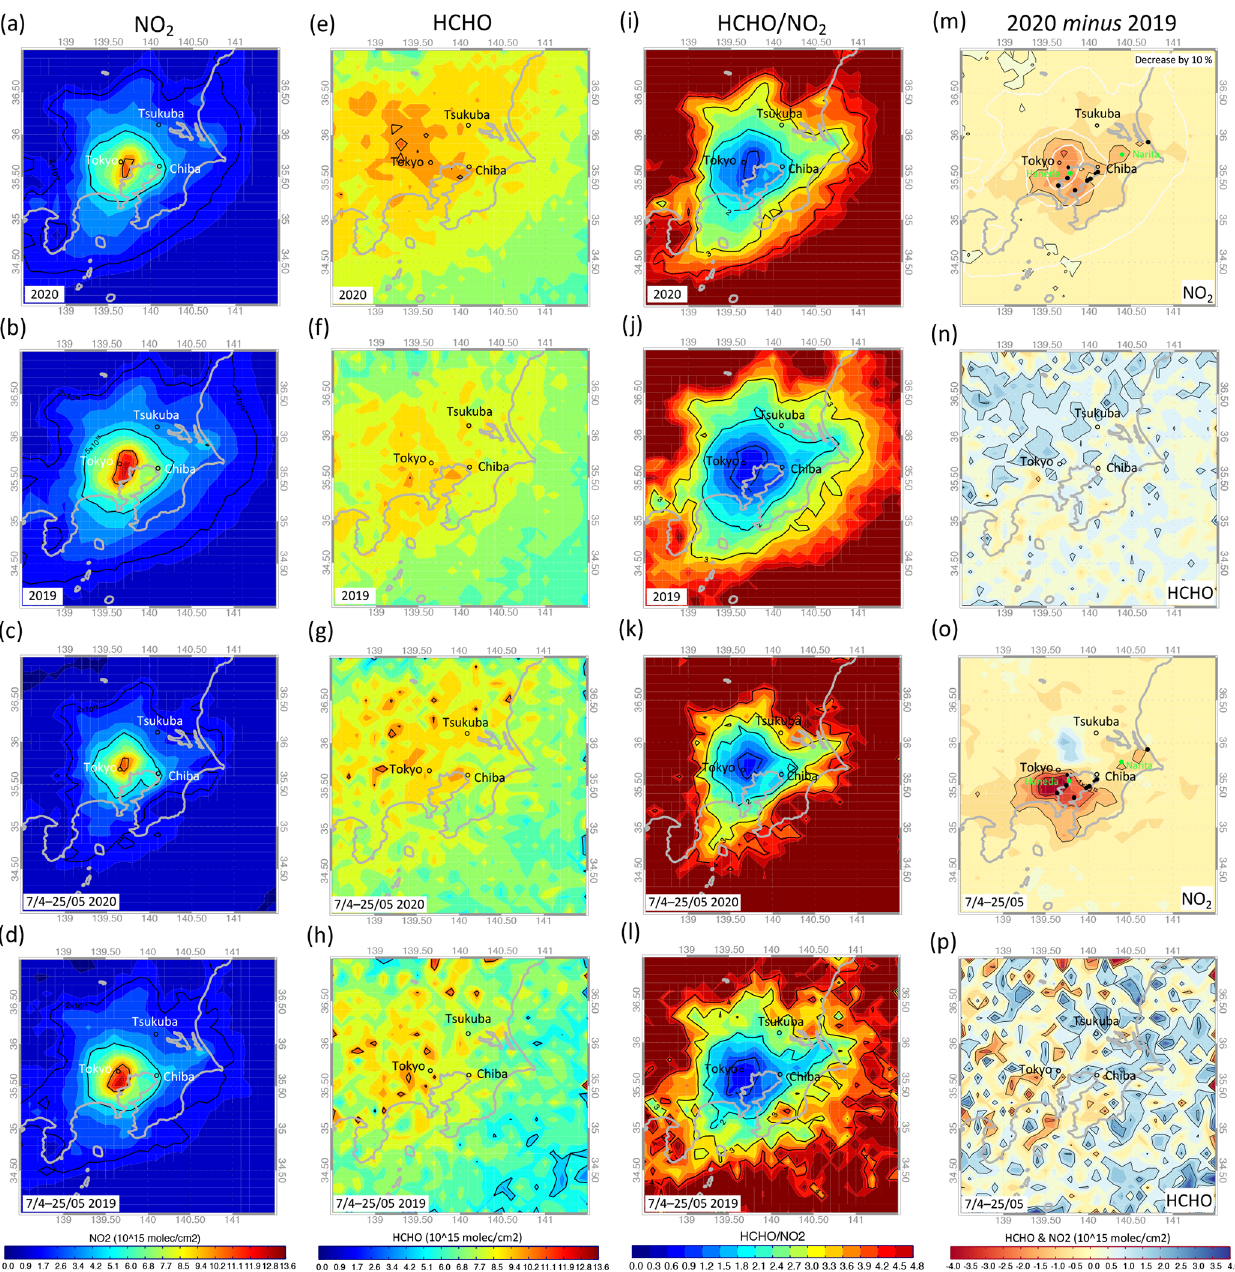
Figure 3. Top two rows of panels: spatial distribution of TROPOMI NO 2 (a, b) , HCHO (e, f) , and HCHO / NO 2 (i, j) in 2020 and 2019, as well as the 2020–2019 differences in NO 2 (m) and HCHO (n) . Bottom two rows of panels: the spatial distribution of TROPOMI observations is as described above but limited to 7 April–25 May (i.e., the state of